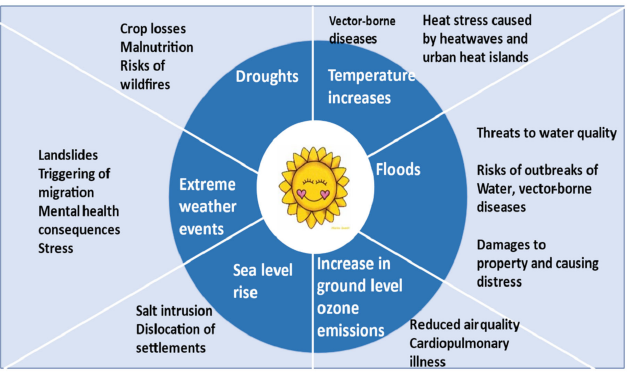
Figure 1. Relations between climate change and some of its health impacts. Source: authors.